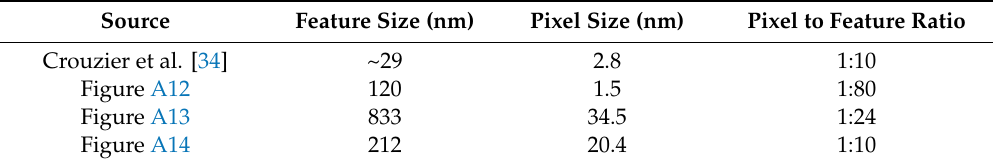
Table A1. Comparison of the limit on pixel size to feature size ratio from Crouzier et al. and this work. Source Feature Size (nm) Pixel Size (nm) Pixel to Feature Ratio Crouzier et al. [34] ~29 2.8 1:10 Figure A12 120 1.5 1:80 Figure A13 833 34.5 Figure A14 212 20.4 1:10